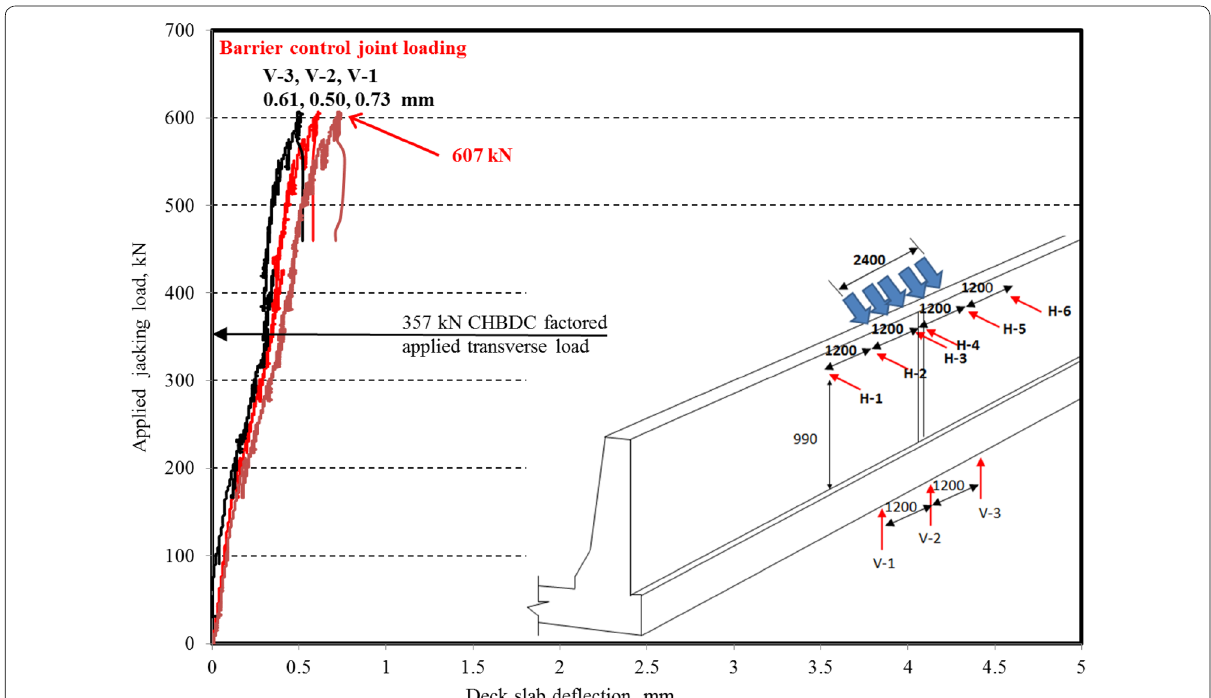
Fig. 11 Load-deflection relationship for the deck cantilever of barrier segment at control joint.